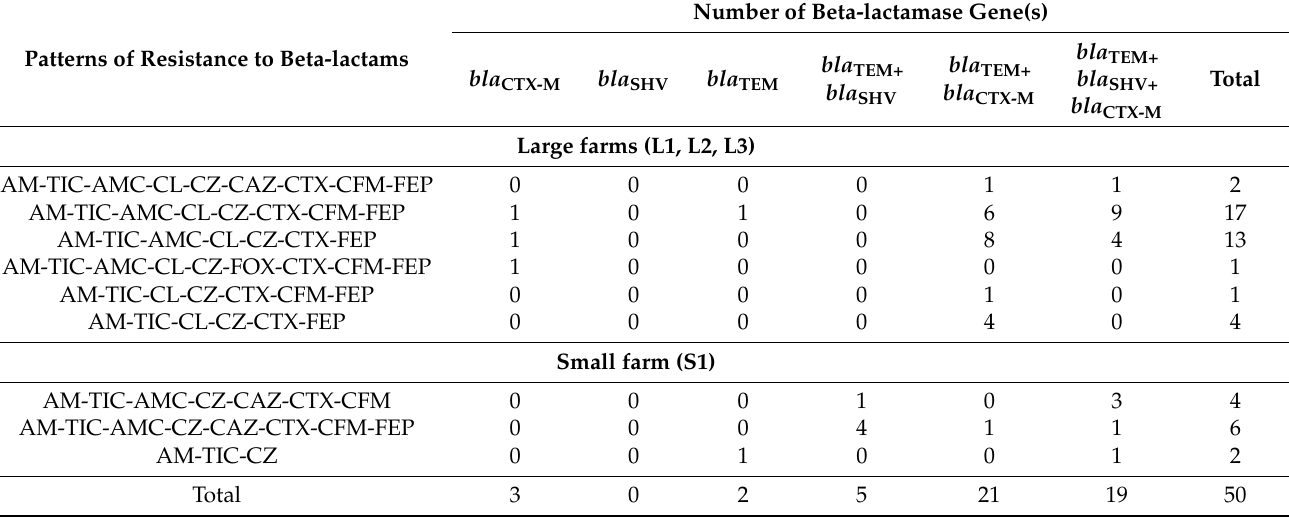
Table 2. Occurrence of pattern for resistance to beta lactams antibiotics and beta-lactamase gene(s) detected in ESBL- producing E. coli . Note: AM–ampicillin, TIC–ticarcillin, AMC–amoxicillin-clavulanic acid, CL–cefalexin, CZ–cefazolin, FOX–cefoxitin, CAZ–ceftazidime, CTX–cefotaxime, CFM–cefixime, FEP–cefepime.